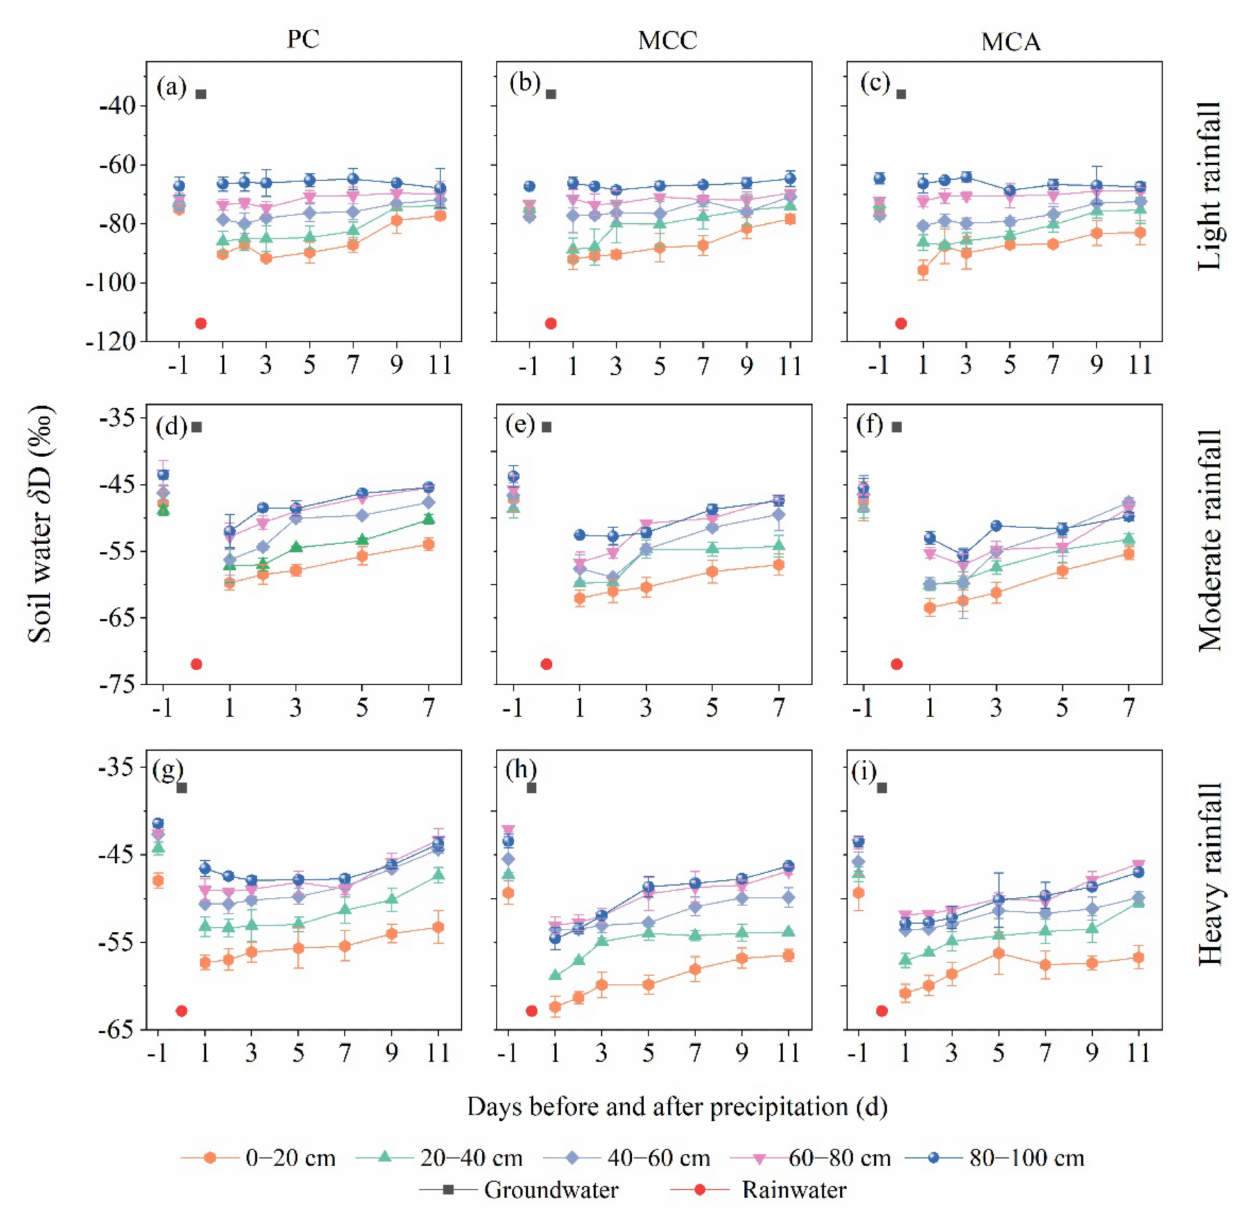
Figure 3. Daily δ D of rainwater, shallow groundwater and soil water in the soil profile in PC ( a , d , g ), MCC ( b , e , h ), and MCA ( c , f , i ). PC: pure C. lanceolata plantation; MCC: mixed plantation with C. lanceolata and C. camphora and MCA: mixed plantation with C. lanceolata and A. cremastogyne